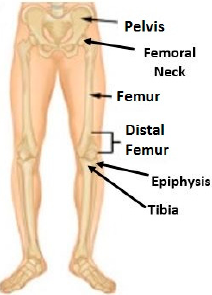
Figure 1. Brief anatomy of lower body bone structure of human body [3].